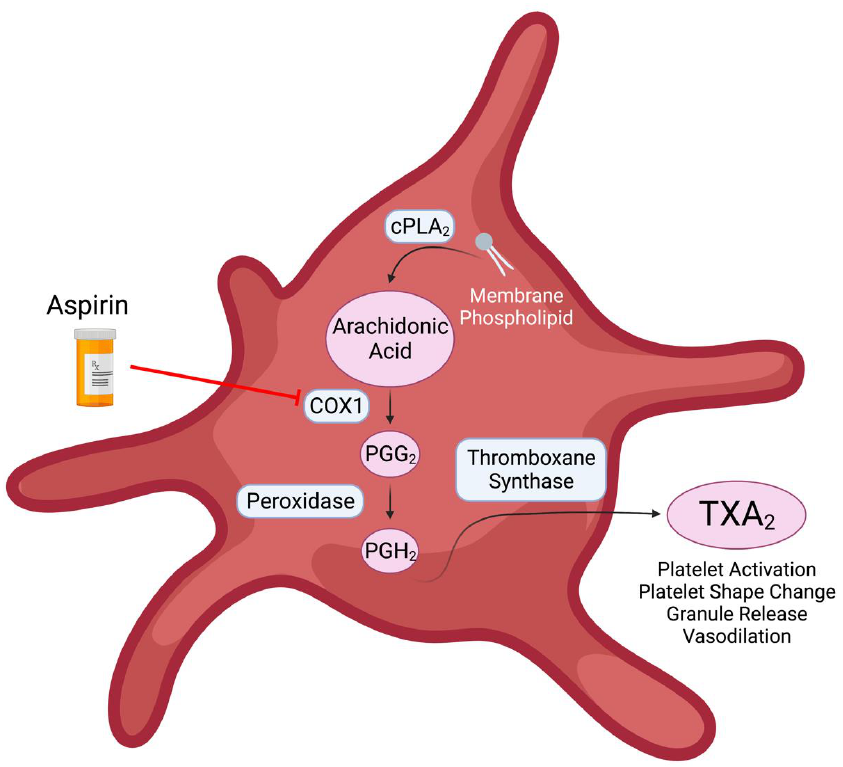
Figure 2. Overview of the inhibition of the Cytochrome c oxidase I (COX-1) by aspirin in platelets.